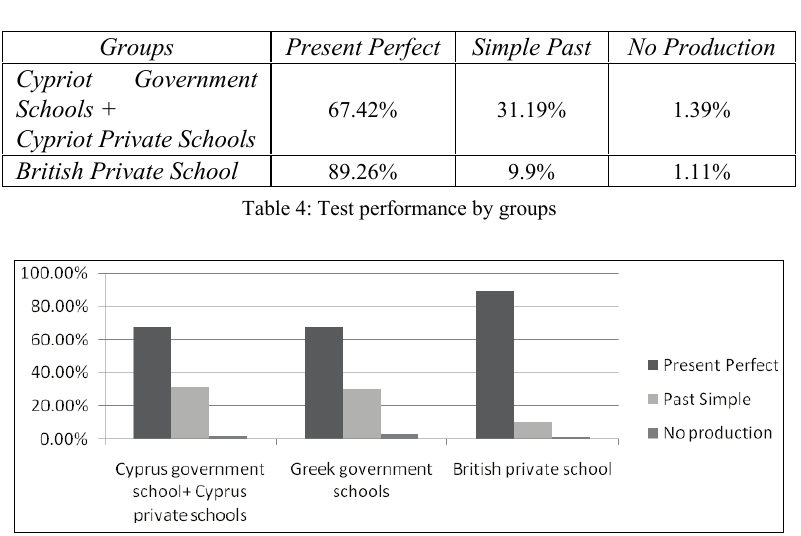
Figure 2: Test performance by